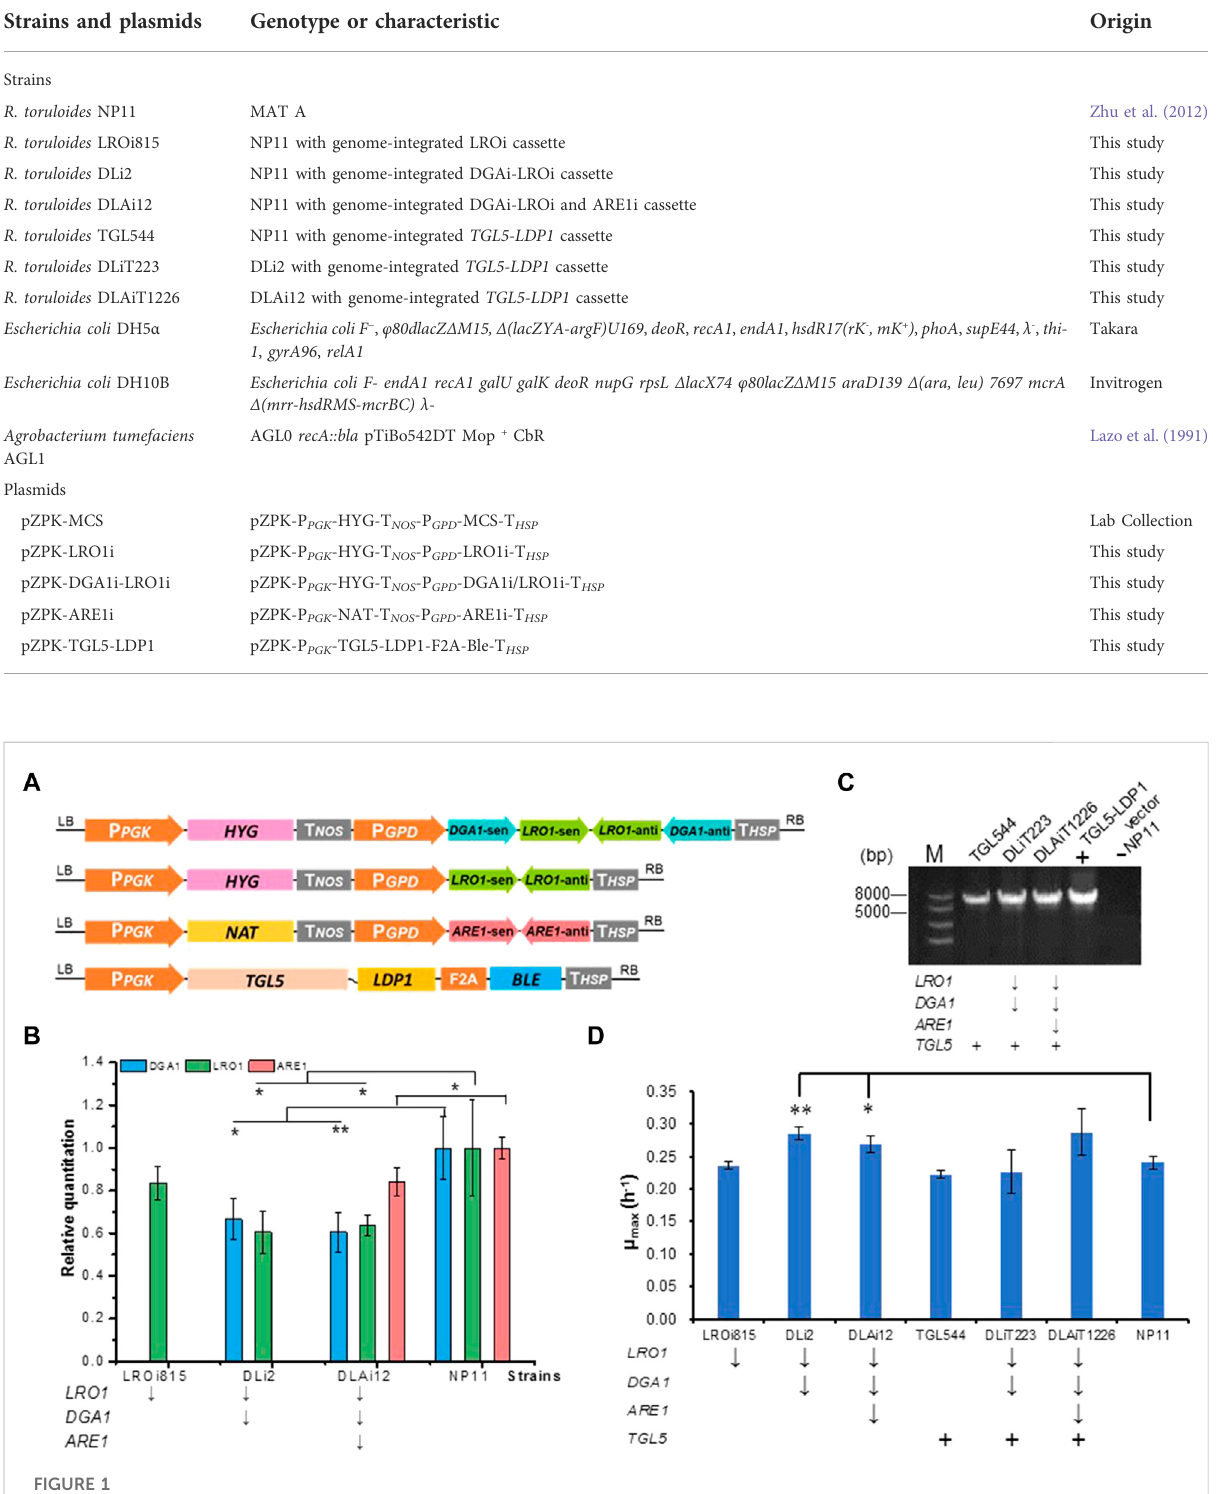
FIGURE 1 Construction and veri fi cation of R. toruloides variants. (A) Diagram of RNAi plasmids and the TGL5 - LDP1 genes overexpression plasmid. Abbreviations: HYG, Hygromycin gene; NAT, Nourseothricin acetyltransferase gene; BLE, Bleomycin gene. (B) DGA1, LRO1, and ARE1 expression levels of different RNAi engineering strains by RT-qPCR. DGA1 , diacylglycerol acyltransferase; LRO1 , phospholipid diacylglycerol acyltransferase; ARE1 ,acyl-CoAsterol acyltransferase;RT-qPCR,reversetranscription quantitative polymerasechain reaction.** p < 0.01, * p < 0.05ofone-way factor AVONA. (C) The veri fi cation of TGL5-LDP1 genes overexpression in engineered strains. Agarose gel (1%) electrophoresis map of TGL5-LDP1 (5670 bp) by PCR ampli fi cation from promoter P PGK (from 777 sites) to BLE (26 sites). (D) Maximum speci fi c growth rate ( μ max ) of strains in YPD medium. The gene labeled with ↓ was knocked down, with + was